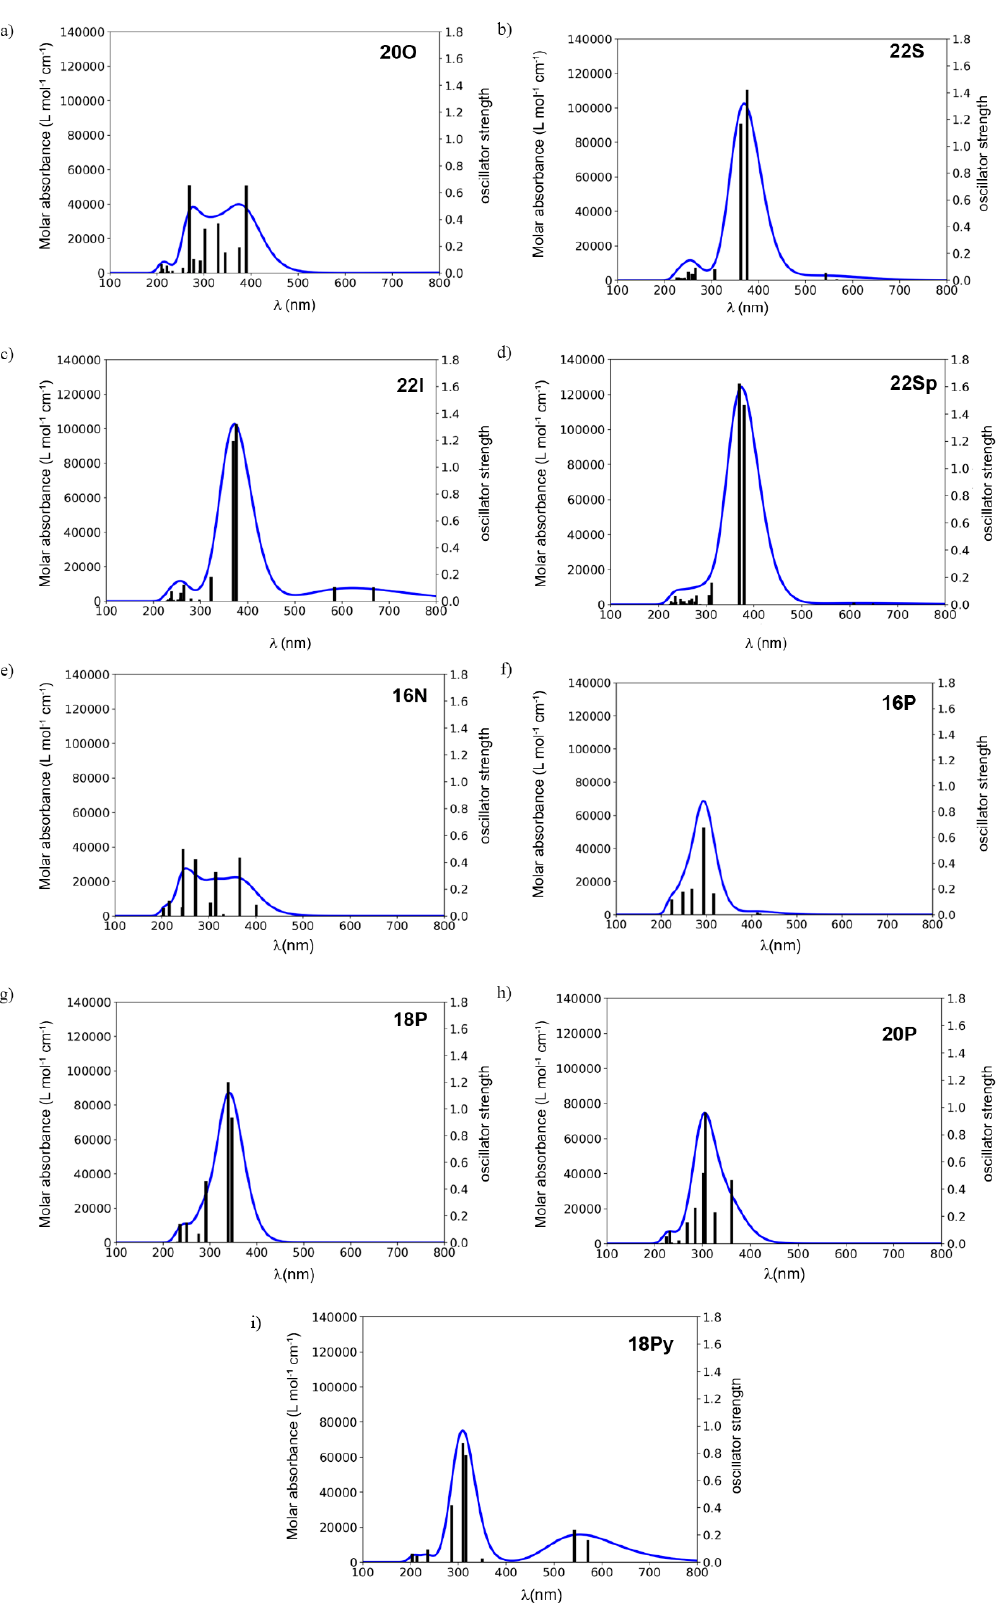
Figure 6. Theoretical UV/vis absorption spectra of unsubstituted Hückel porphyrinoids together with the TDDFT/CAM-B3LYP oscillator strengths: ( a ) (20)orangarin, ( b ) (22)smaragdyrin, ( c ) (22)isosmaragdyrin, ( d ) (22)sapphyrin, ( e ) (16)norcorrole, ( f ) (16)porphyrin, ( g ) (18)porphyrin, ( h ) (20)porphyrin and ( i ) porphycene.